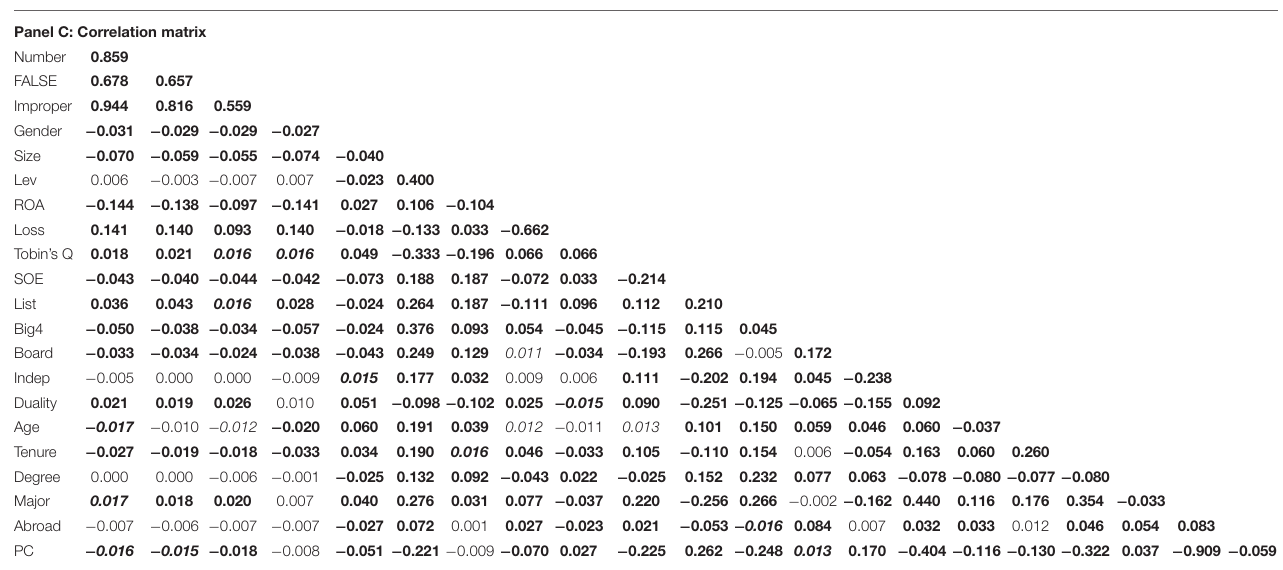
Panel B: Univariate comparisons Violation